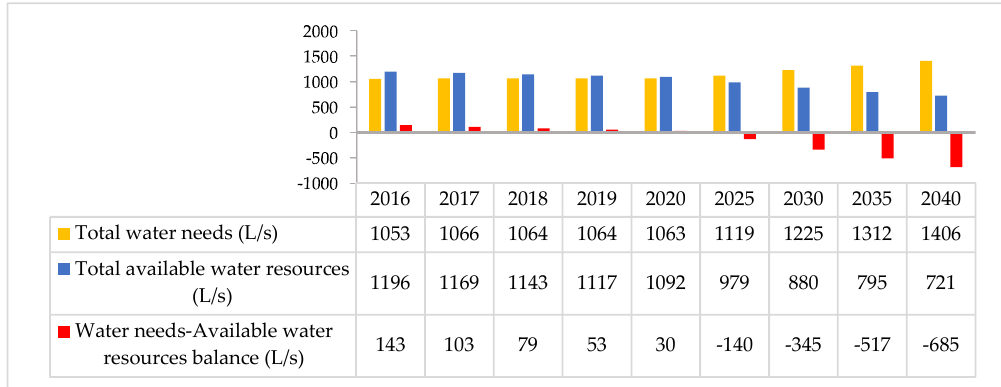
Figure 3. Estimation of drinking water needs—available water resources balance sheet of Oujda municipality (Current scenario).